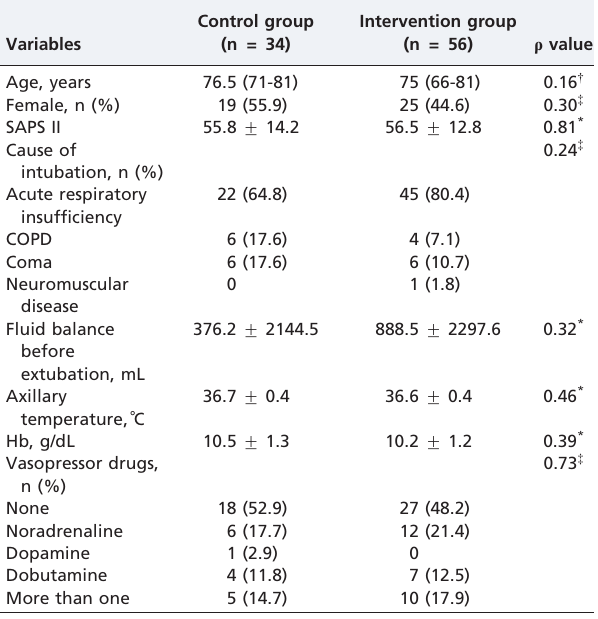
Table 5 - Clinical and demographic characteristics of the patients treated with NPPV